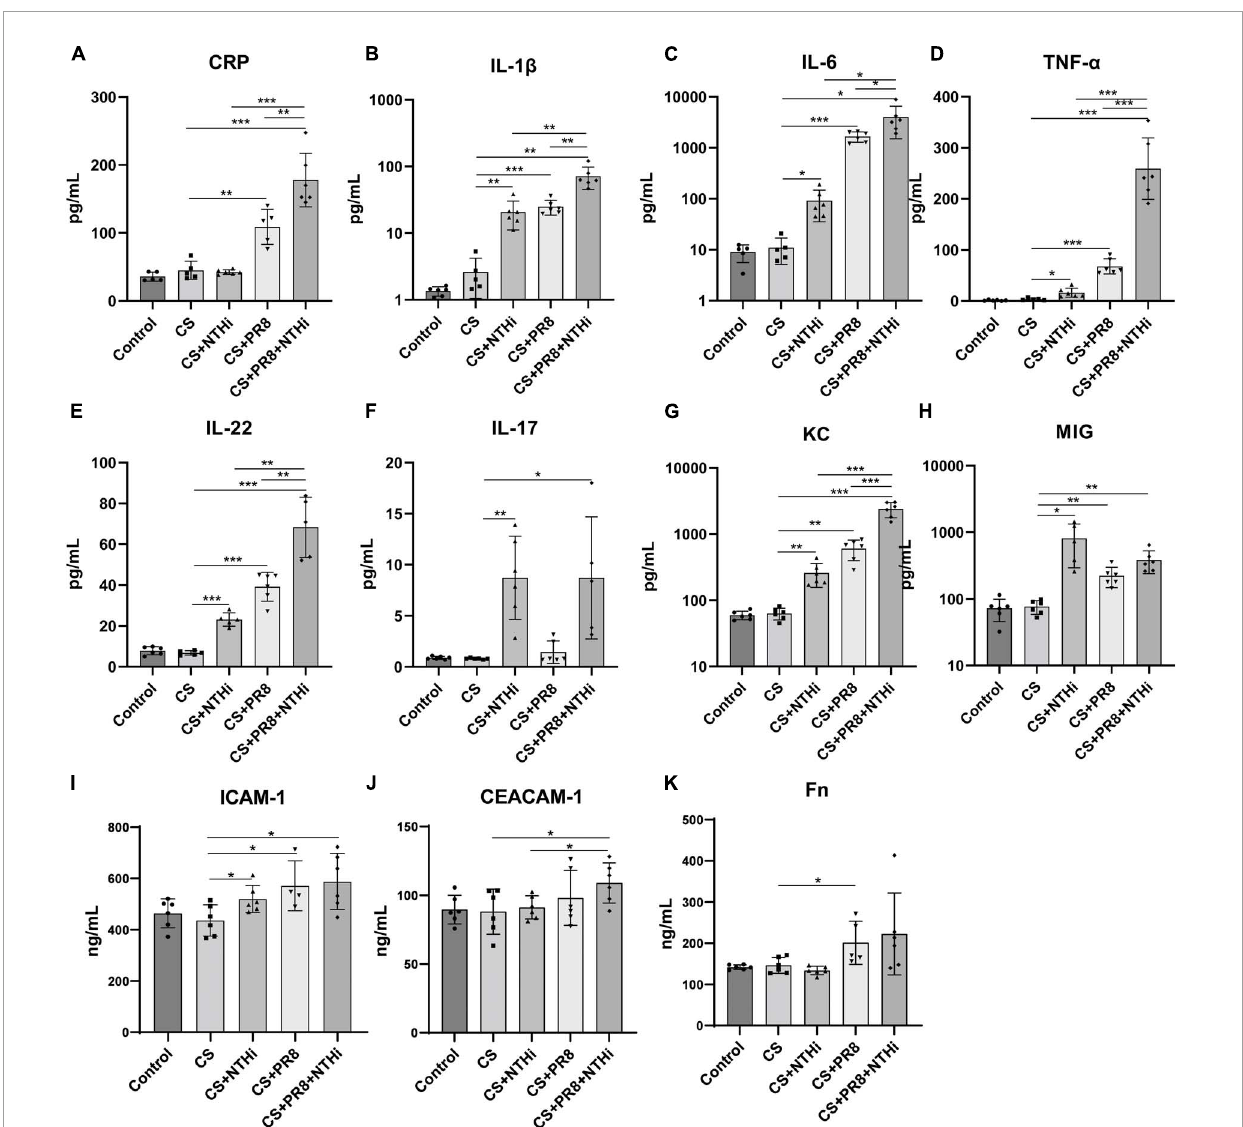
FIGURE7 Cytokine and adhesion molecule expression in lung homogenates of AECOPD mice. The levels of CRP (A) , IL-1 β (B) , IL-6 (C) , TNF- α (D) , IL-22 (E) , IL-17 (F) , KC (G) , MIG (H) , ICAM-1 (I) , CEACAM-1 (J) , and Fn (K) were measured by the Bio-Plex Mouse Cytokines assay or ELISA. Data are expressed as mean ± SD ( n = 6 in each group). * p < 0.05, ** p < 0.01, and *** p <